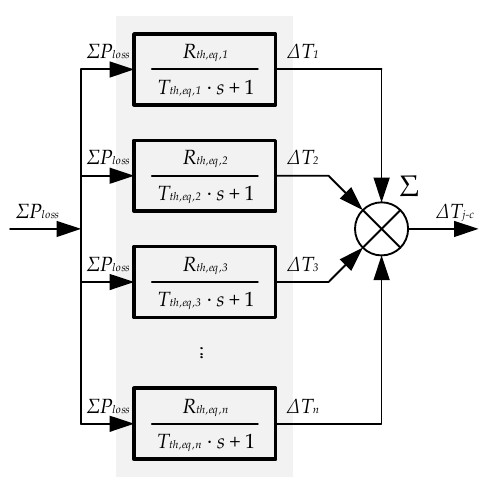
Figure 21. Equation based simulator block diagram to obtain the 1 × 1 RC model.